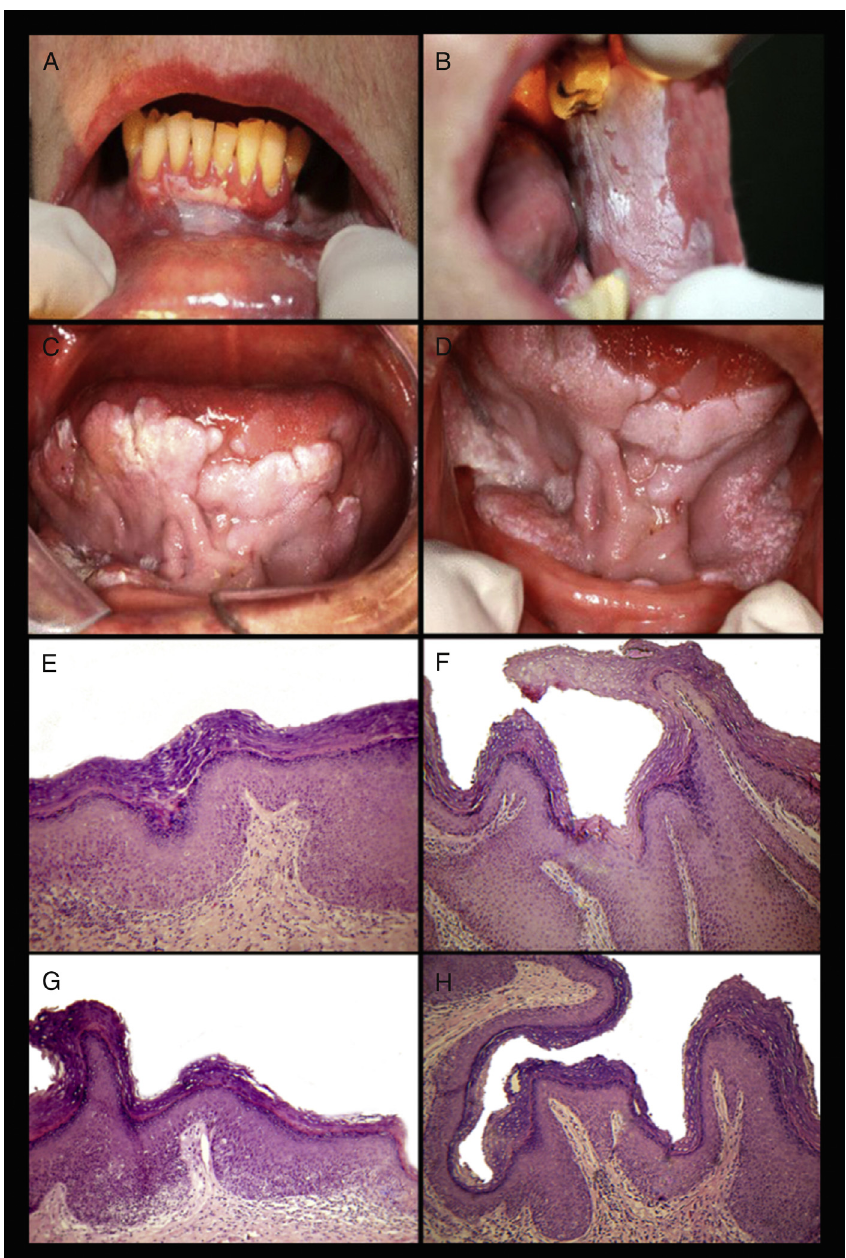
Figure 1 (A) Proliferative verrucous leukoplakia (PVL) in the lower attached gingival, vestibular sulcus and gradually extended along left alveolar ridge. (B) PVL in the buccal mucosa with different clinical patterns: larger areas of homogeneous leukoplakias and spot areas of thickening of the keratinization and/verrucous surface. (C and D) PVL in ventral tongue and floor of mouth with exophytic appearance and focal area of granular pattern in both alveolar ridges. (E) Histopathological view showing acanthosis and hyperkeratosis with mild dyplasia. (F) Exophytic, hyperkeratotic lesion with prominent verruciform or papillary surface and acanthosis forming blunt projections into the lamina propria. (G) Hyperkeratosis, acanthosis, irregularity of the basal layer and some areas of epithelial atrophy. (H) Hyperkeratosis with droplet-shaped epithelial projections and intact lamina propria (HE, original magnification 40 ×